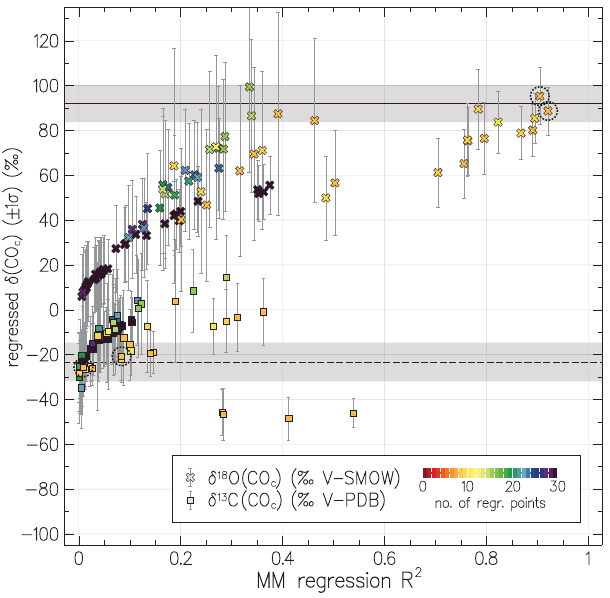
Figure 6. Results of the regression calculation with the MM. Shown with symbols are the contamination source isotope signa- tures δ (CO c ) as a function of the respective coefficient of determi- nation ( R 2 ) . Colour denotes the number of samples in each sub- set selected. Solid and dashed lines present the best guess ± 1 stan- dard deviation of the mean for the δ 18 O(CO c ) and δ 13 C(CO c ) esti- mates. Dashed circles mark the estimates obtained at highest R 2 for δ 18 O(CO c ) regression (above 0.9). See text for